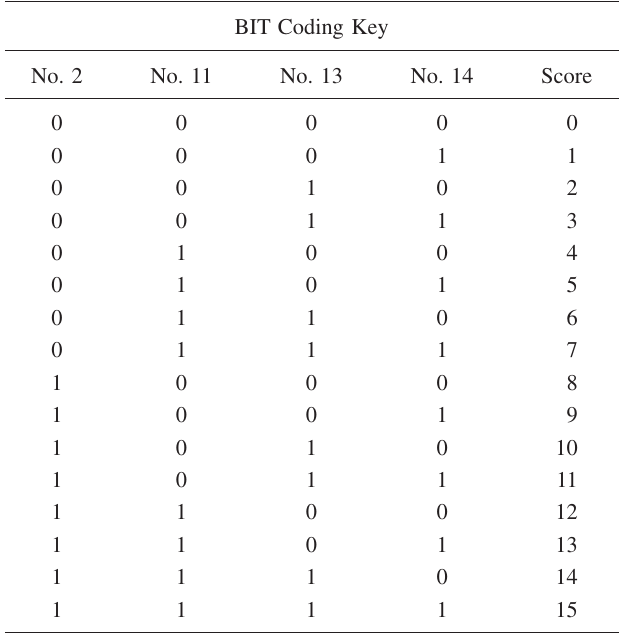
TABLE III. Key to the BIT Coding system, showing all the possible combinations of student’s answers to N3-concept FCI questions, with “0” denoting an incorrect response and “1”